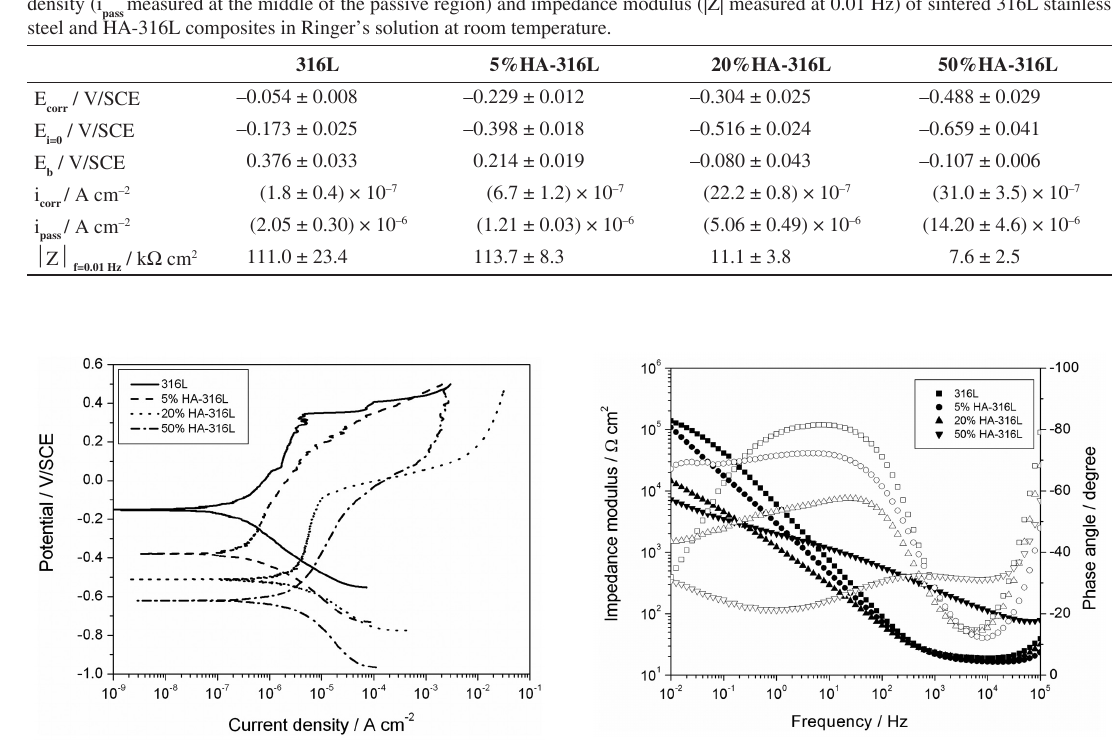
), passive current corr